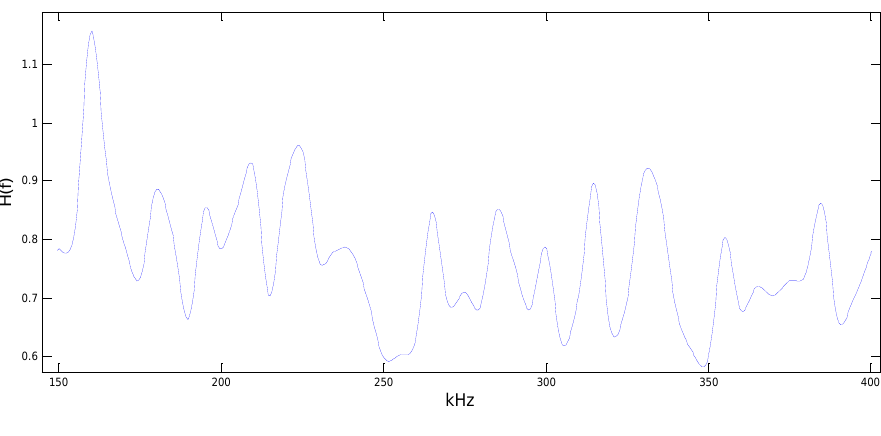
Figure 10. The transmission coefficients H ( f